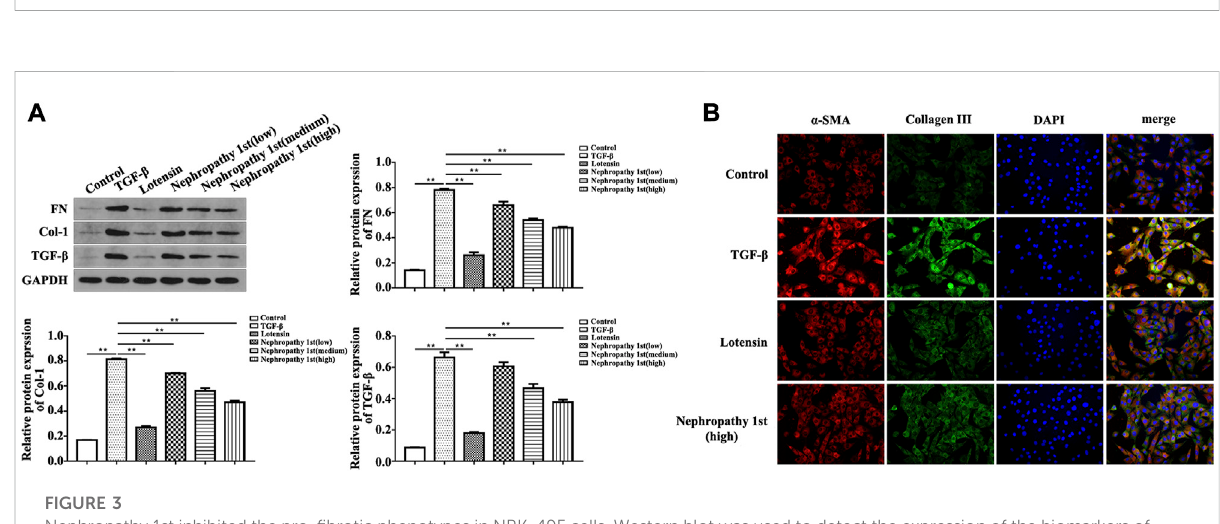
col-1. Lotensin and the three concentrations of Nephropathy 1st signi fi cantly reversed TGF- β 1 effects on Fn and col-1 expression. (Figure 3A). Immuno fl uorescence staining also showed that TGF- β 1 treatment promoted the expression of α -SMA and collagen III, which was abrogated by lotensin or Nephropathy 1st treatment (Figure 3B).